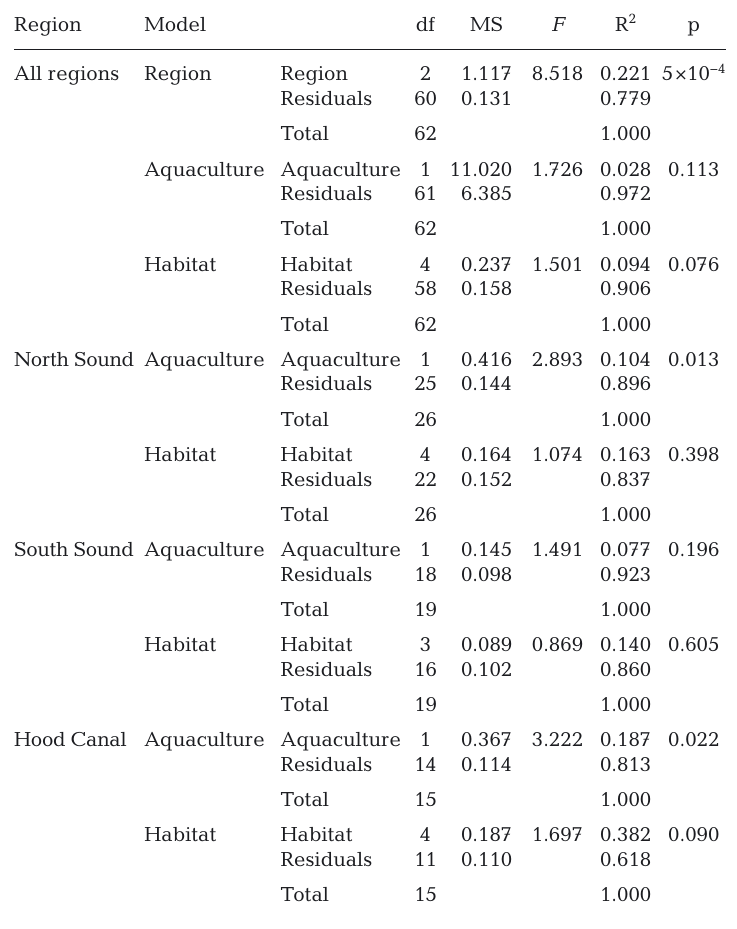
Table 4. Summary of PERMANOVA models for all regions combined, North Sound, South Sound, and Hood Canal, which include aquaculture presence (aquaculture) or mesohabitat type (habitat) as